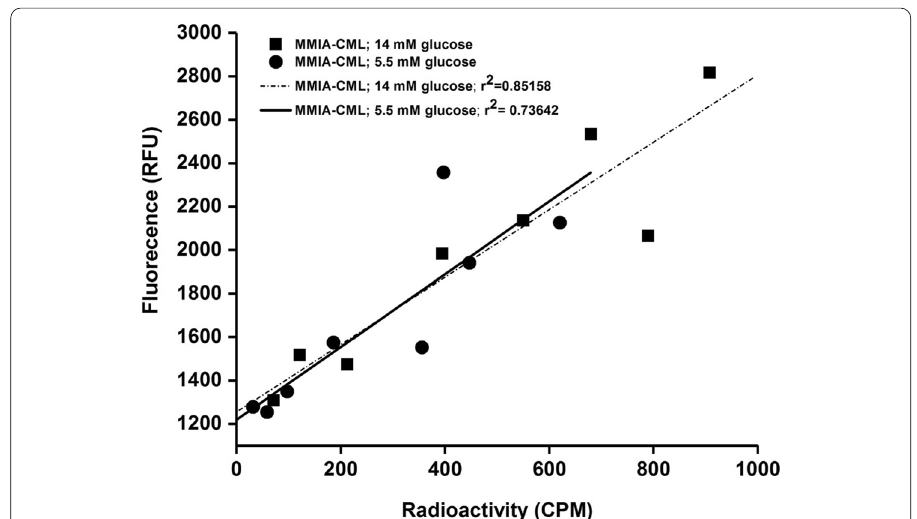
Fig. 1 Correlation between fluorescence and gamma well-counting methods. Human umbilical vein endothelial cells (HUVEC) were cultured in a medium enriched with 5.5 mM, which mimics normoglycemic, or 14 mM glucose, which imitates hyperglycemic conditions in advance of the incubation with multimodal probes targeted at RAGE